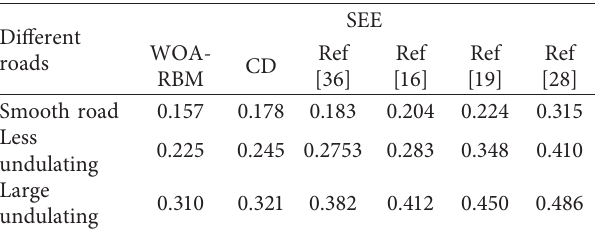
Table 5: The effect of different roads on the performance of the